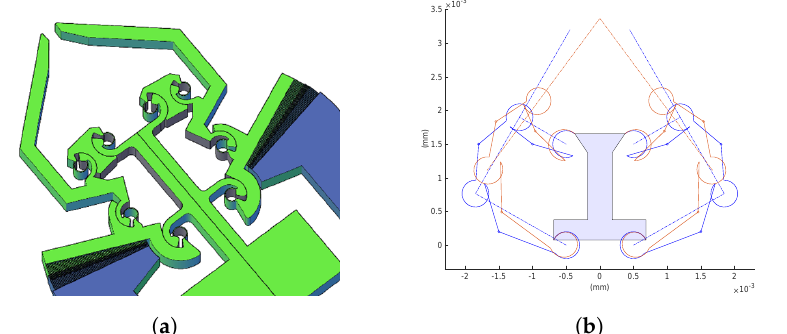
Figure 5. MEMS-based gripper with curved beams. ( a ) CAD layout. ( b ) Matlab model: (red) deformed configuration, (blue) undeformed configuration.